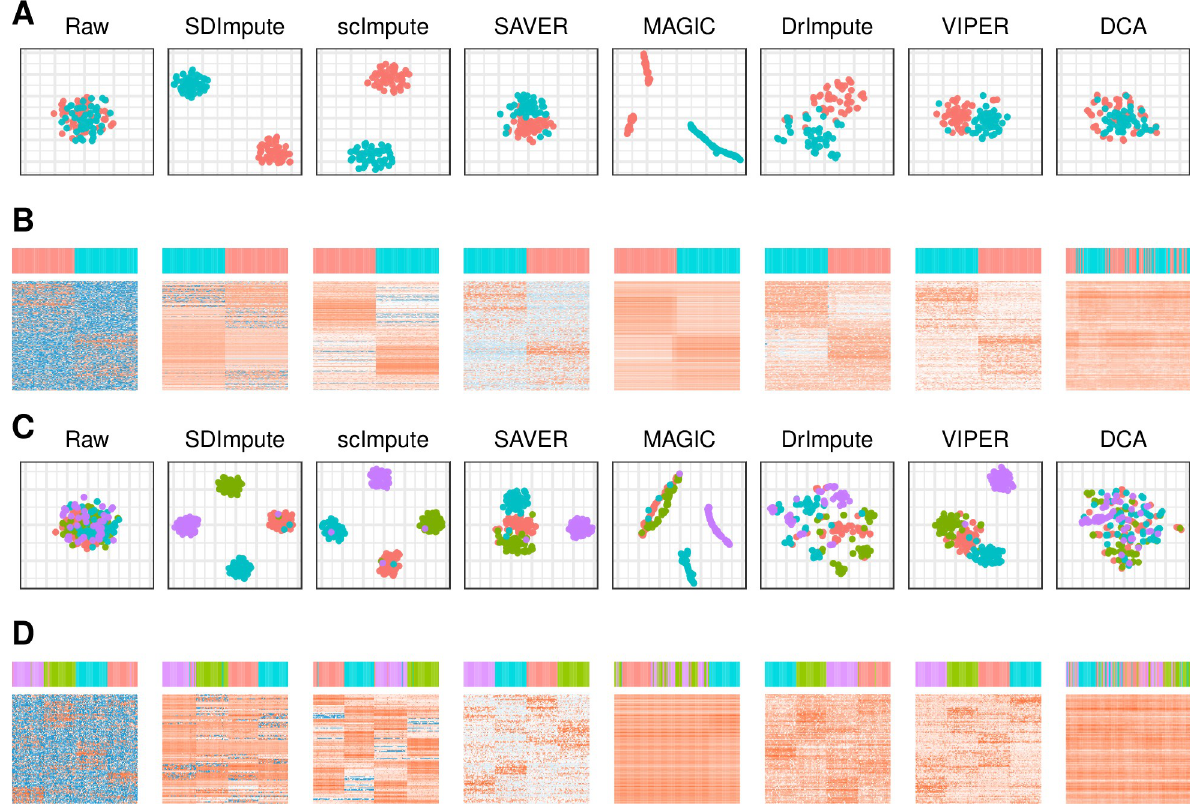
Fig 3. SDImpute improves the visualization of cell types in simulated datasets. (A), (C) Visualization after t-SNE [27] dimensionality reduction in simulated data of two cell types and four cell types, respectively. (B), (D) Heat maps of top 500 differential expression genes (DEGs) in simulated data of two cell types and four cell types,